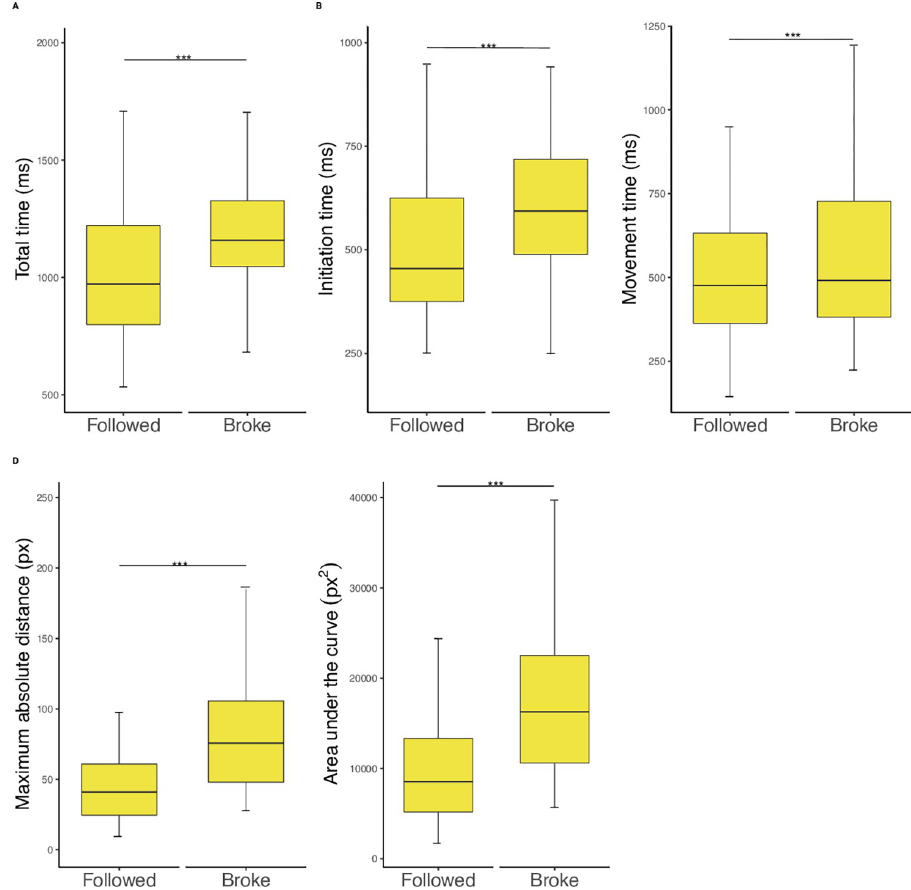
Fig 3. Reaction times and mouse trajectories across responses to rules in rule-breakers. Significance: � = p < .05, �� = p < .01, ��� = p < .001. The top and bottom whiskers are set to the highest/lowest value of the dataset that are included in the 1.5IQR